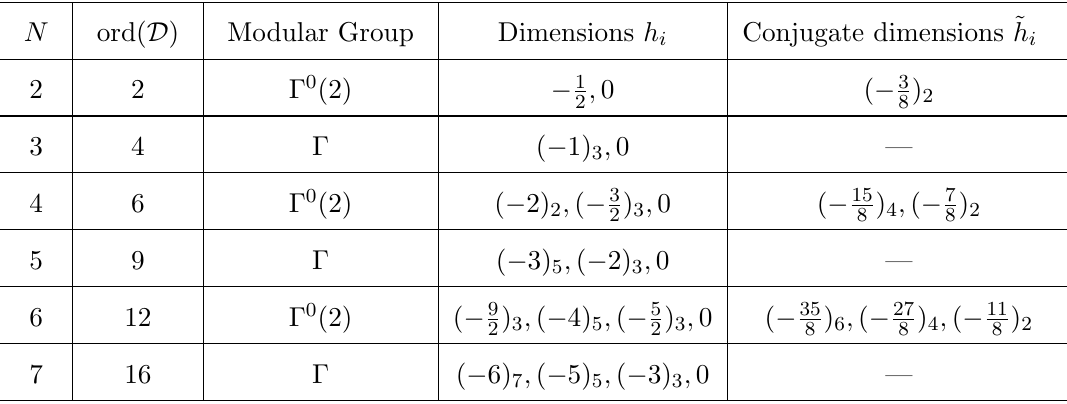
Table 5 . Summary of modular differential operators that annihilate the vacuum characters of vertex operator algebras for = 4 super Yang-Mills theories. Provided are the order of the minimal N modular differential operator that annihilates the vacuum character, the modular subgroup under which the corresponding differential equation is invariant, and the lists of solutions of the indicial equation and, when relevant, the conjugate indicial equation. The notation ( h i ) d represents that i the dimension h i occurs with multiplicity d i